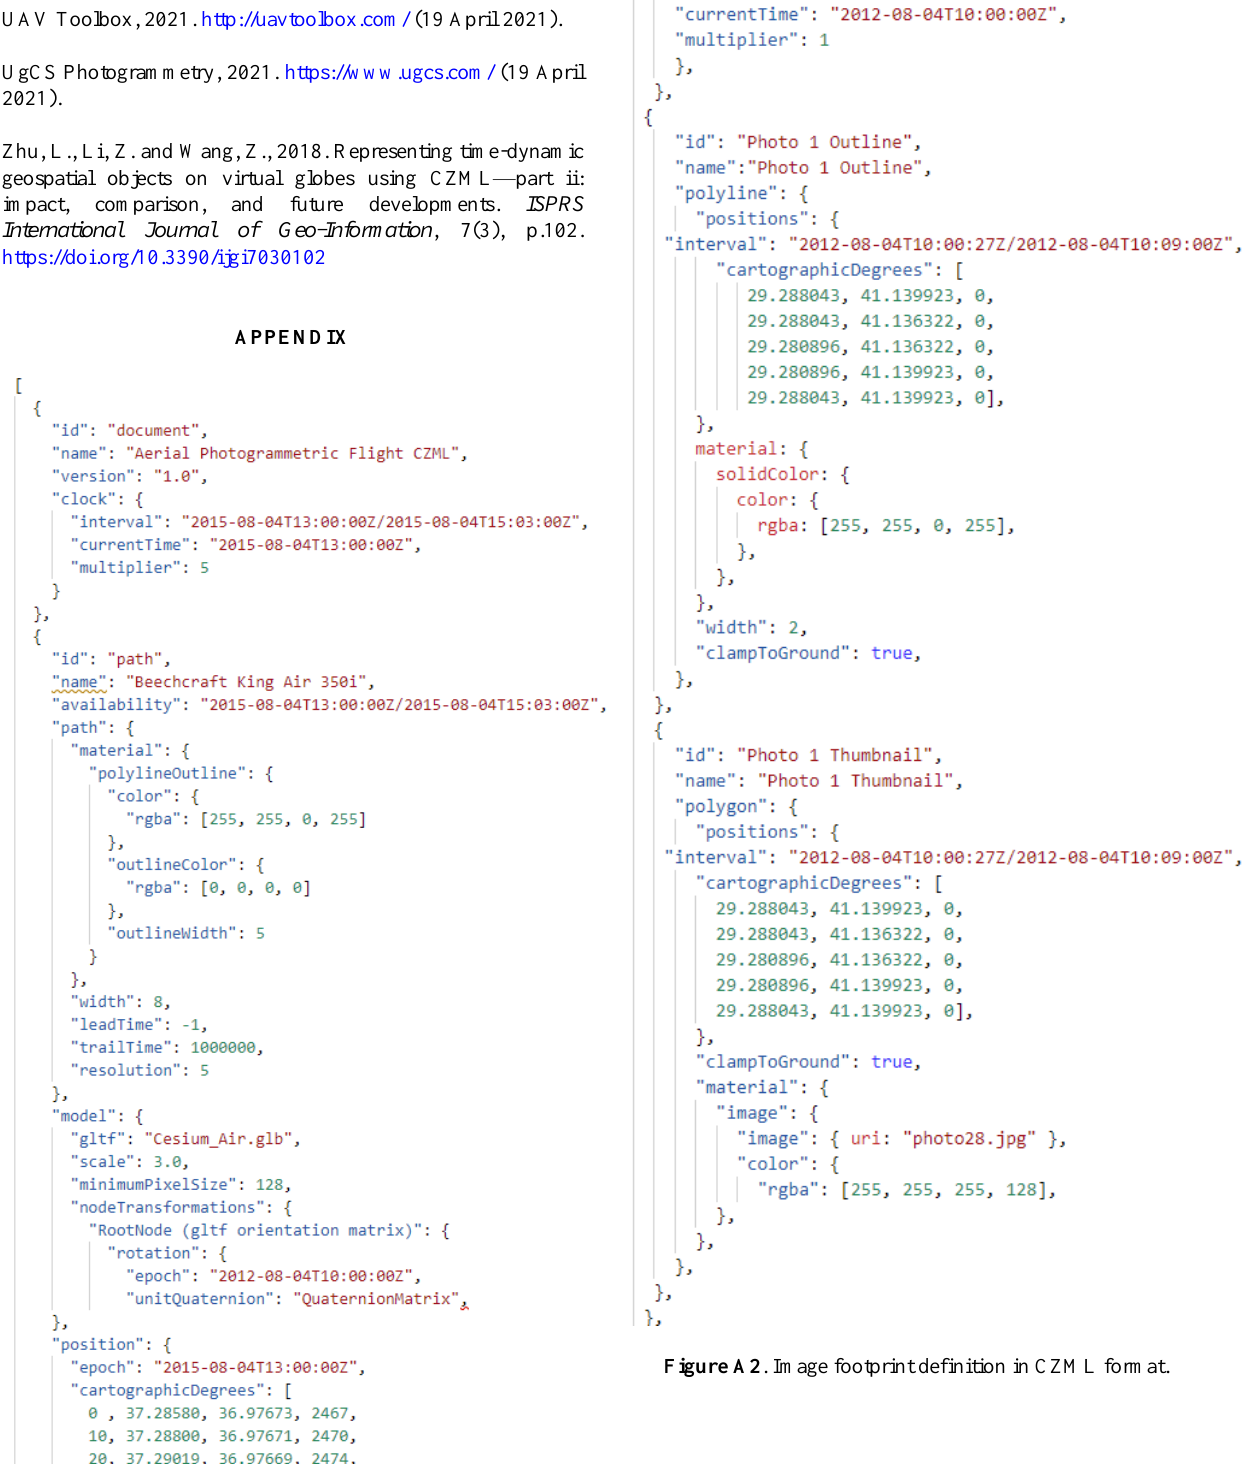
Figure A2 . Image footprint definition in CZML